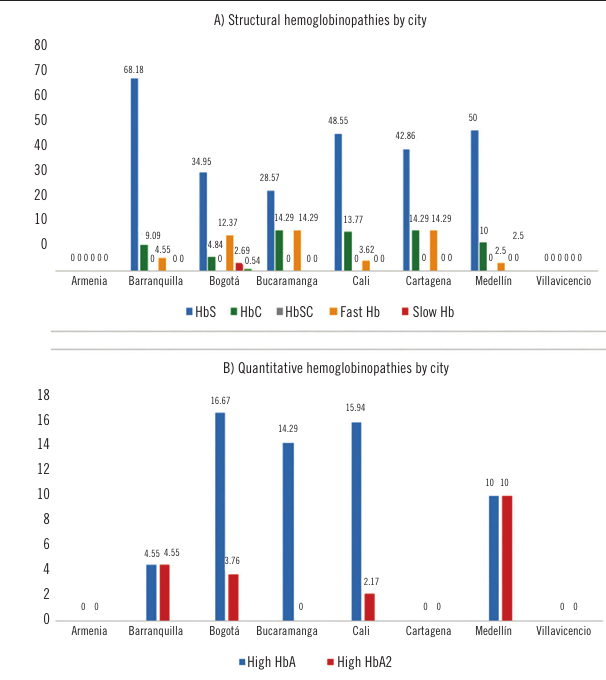
figurE 4 − Percentage distribution of structural and quantitative hemoglobinopathies by city Tabulated data correspond to results with a confirmatory analysis for each Hb variant.